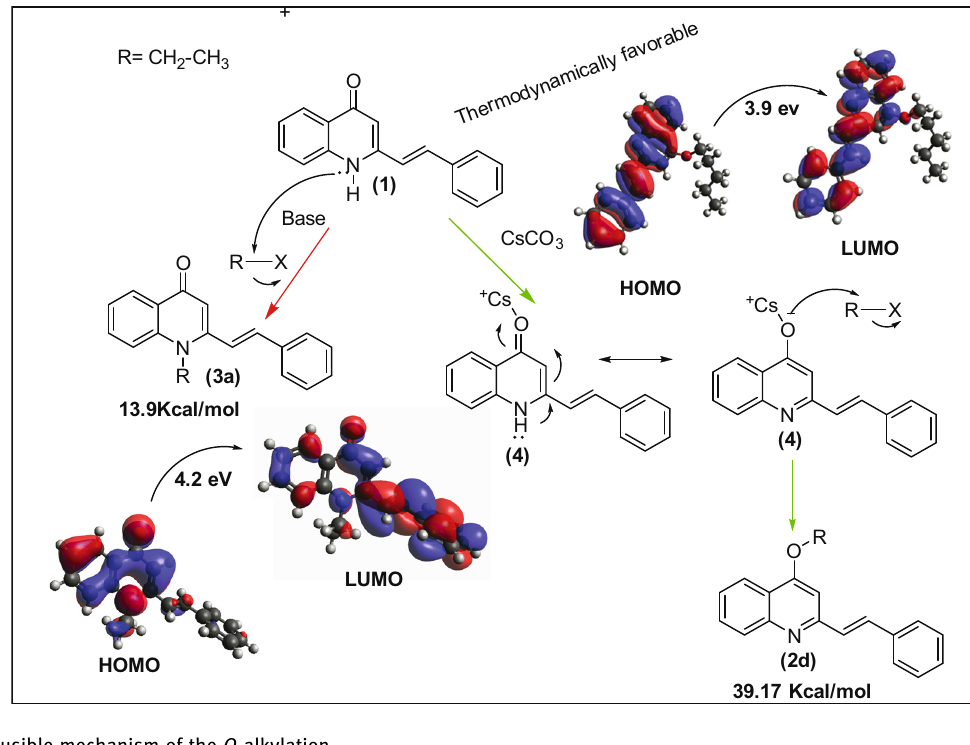
Figure 5: Plausible mechanism of the O - alkylation.